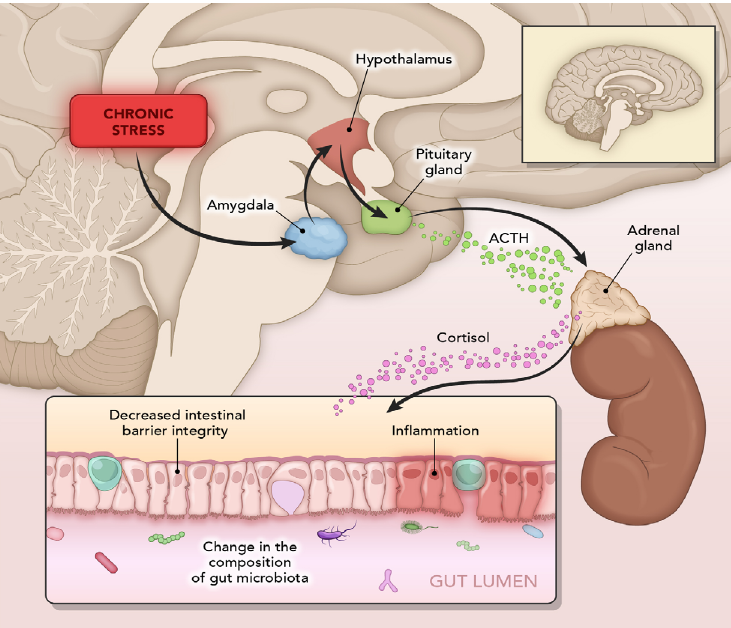
Figure 3. Mechanisms of stress. In a stressful event, the amygdala sends a signal to the hypothalamus, which triggers an alert through the nervous system. This releases a flood of stress hormones, including adrenaline and cortisol. Fight-or-flight response slows down digestion and increases gut sensitivity. Stress harms the intestinal barrier and can initiate a vicious cycle of inflammation. ACTH: adrenocorticotropic